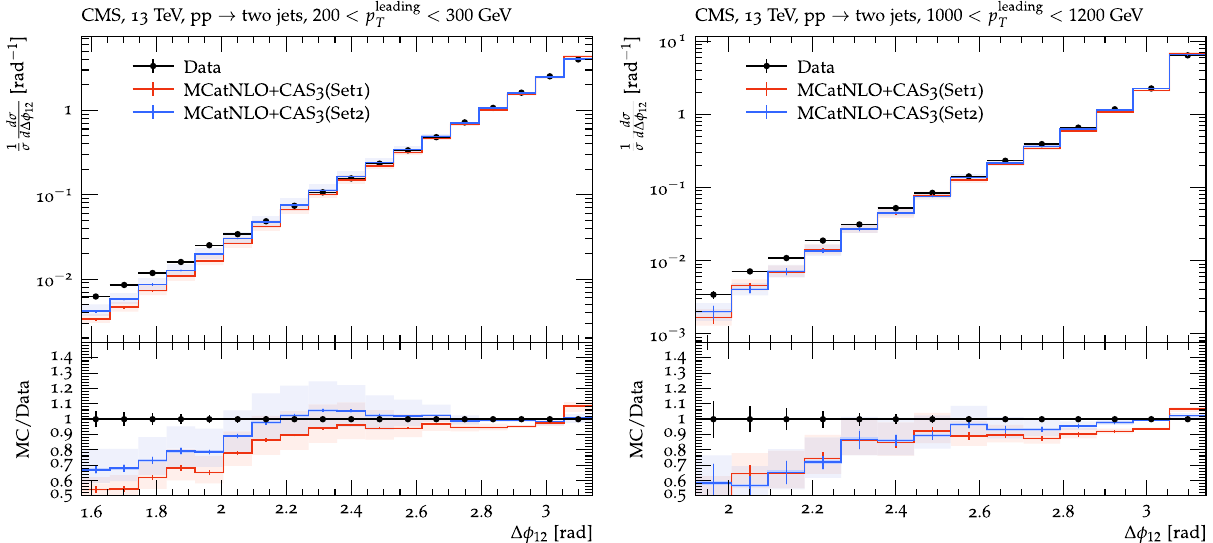
> 200 GeV (left) and p leading > 1000 GeV (right) as measured by CMS [26] compared with Fig. 6 Azimuthal correlation (cid:2)φ 12 for p leading T T predictions from MCatNLO+CAS3. Shown are theuncertaintiescoming from the scalevariation (as describedinthe text)aswell as theuncertainties coming from the TMD